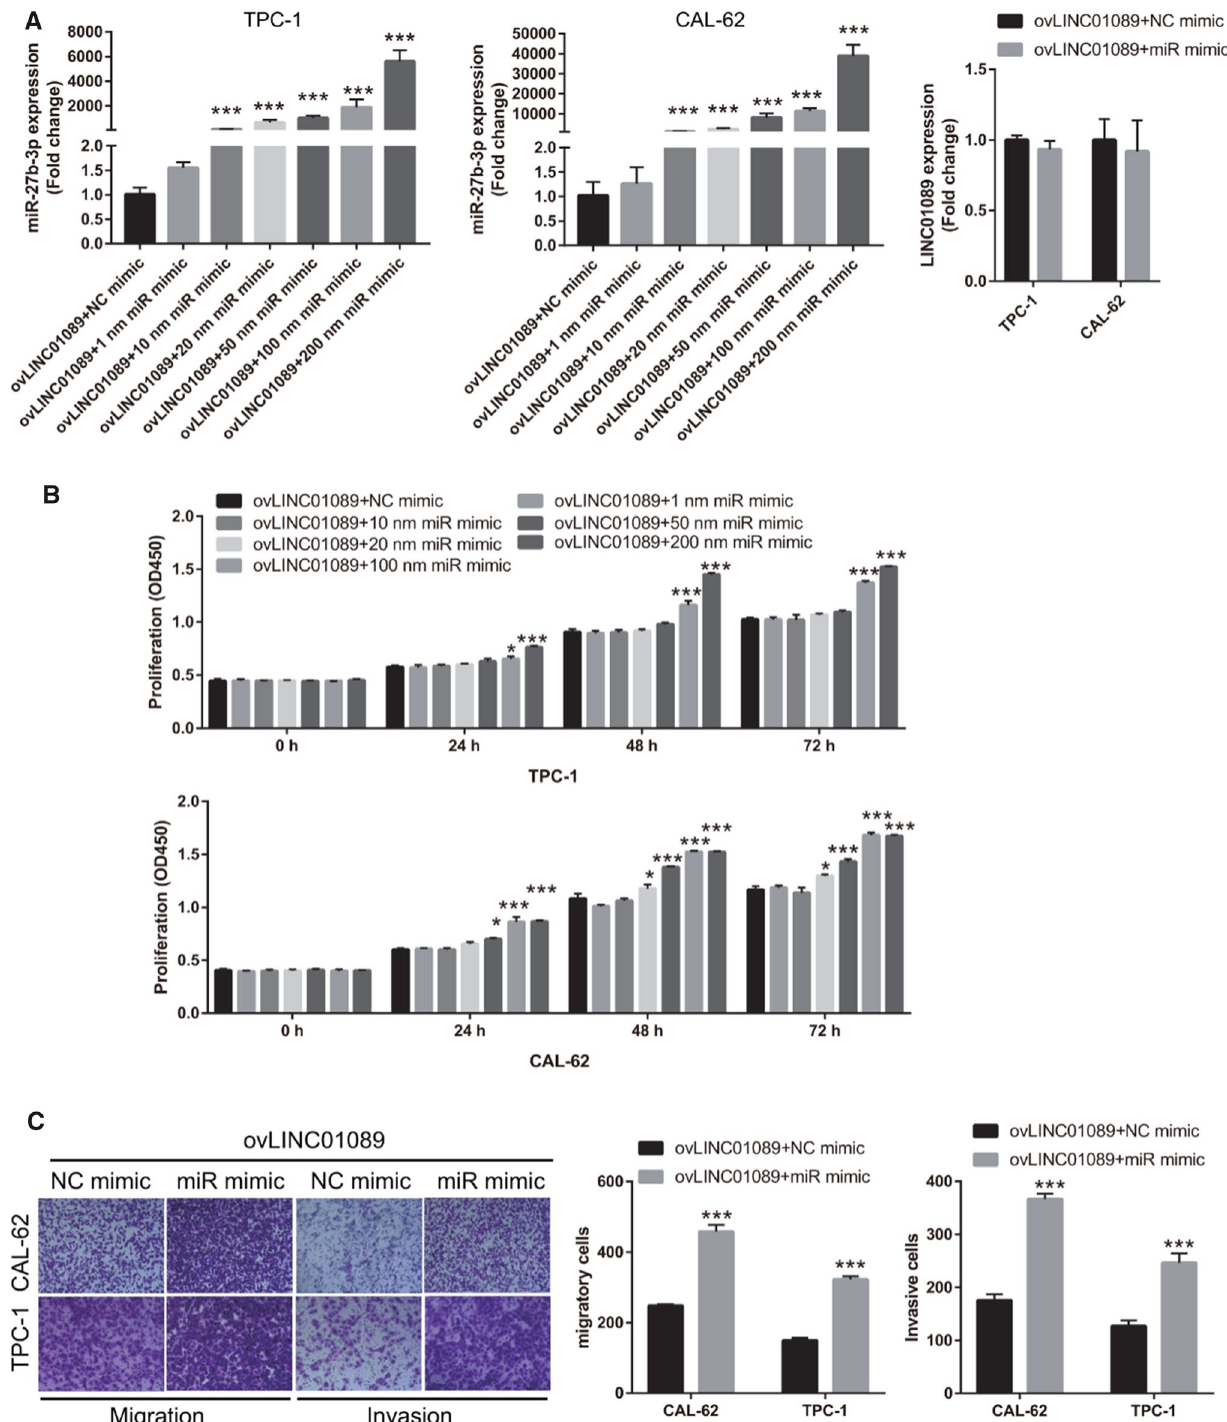
Fig. 4 miR-27b-3p overexpression promoted the malignant progression potential of ovLINC01089-transfected thyroid cancer cells. A miR- 27b-3p expression in TPC-1 and CAL-62 cells was measured via RT-qPCR after co-transfection with ovLINC01089 and the different concen- trations of miR (miR-27b-3p) mimic. LINC01089 expression in TPC-1 and CAL-62 cells was measured via RT-qPCR after co-transfection with ovLINC01089 and 200 nM miR mimic. B Proliferation was evaluated by the CCK-8 assay after co-transfection ovLINC01089 and the different concentrations of miR mimic. C Migration and invasion were assessed by the Transwell assay after co-transfection ovLINC01089 and 200 nM miR mimic (magnification, 100×). Histograms represent the mean ± SD (n = 3). *p < 0.05 and ***p <